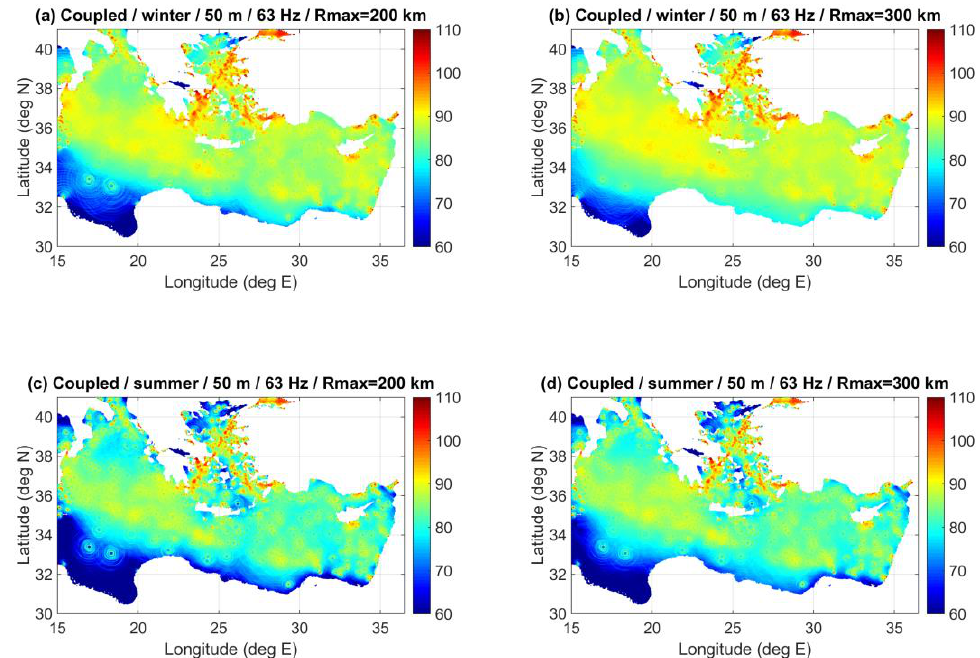
Figure 14. Predicted noise distribution (dB re 1 µ Pa 2 /Hz) at a depth of 50 m, at a frequency of 63 Hz from the noise source distribution of Figure 10, assuming source depth of 5 m and spectral source level of 165 dB re 1 µ Pa 2 /Hz @ 1 m, from coupled-mode calculation for the winter ( a , b ) and summer ( c , d ) SVP, applying a limitation of calculation range to 200 km ( a , c ) and 300 km ( b , d ) from each noise source.